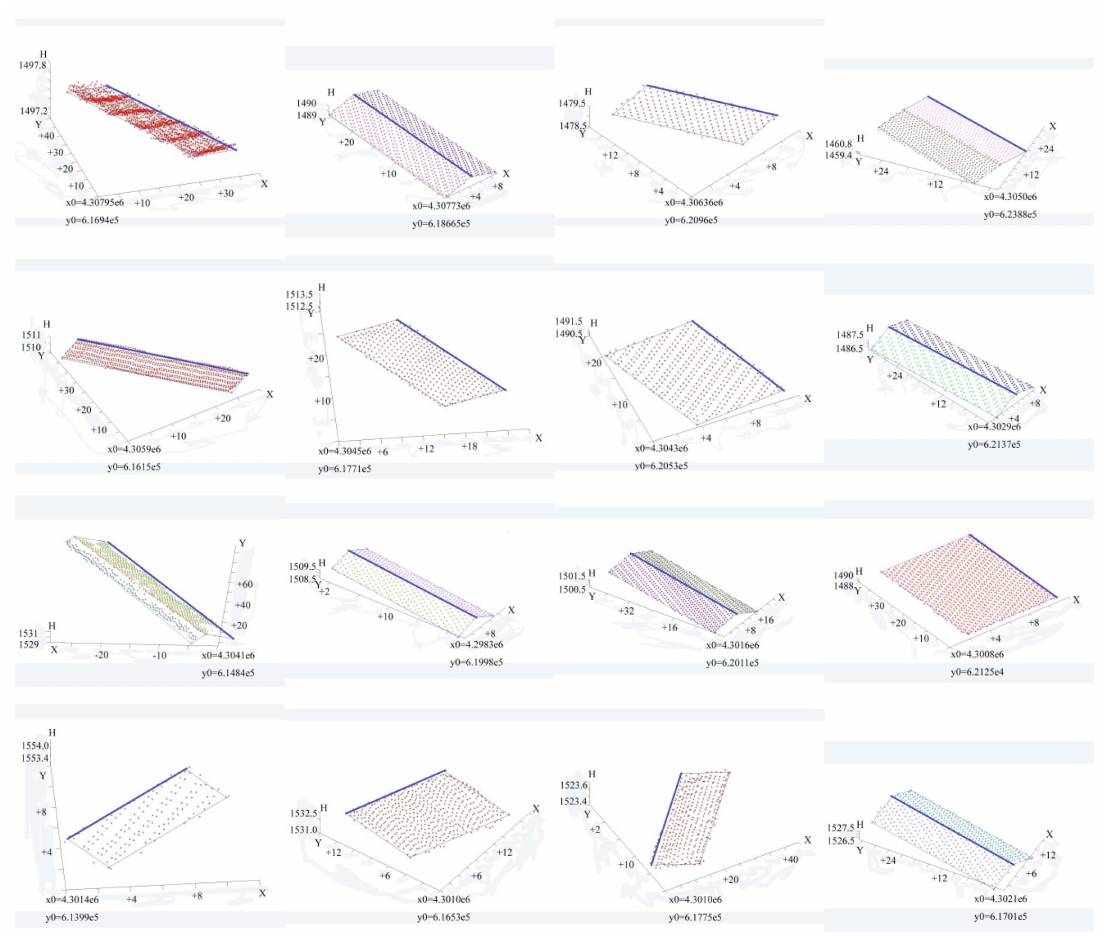
Figure 4. The 16 building roofs and 3D line segments (blue lines) extracted from the LiDAR data.